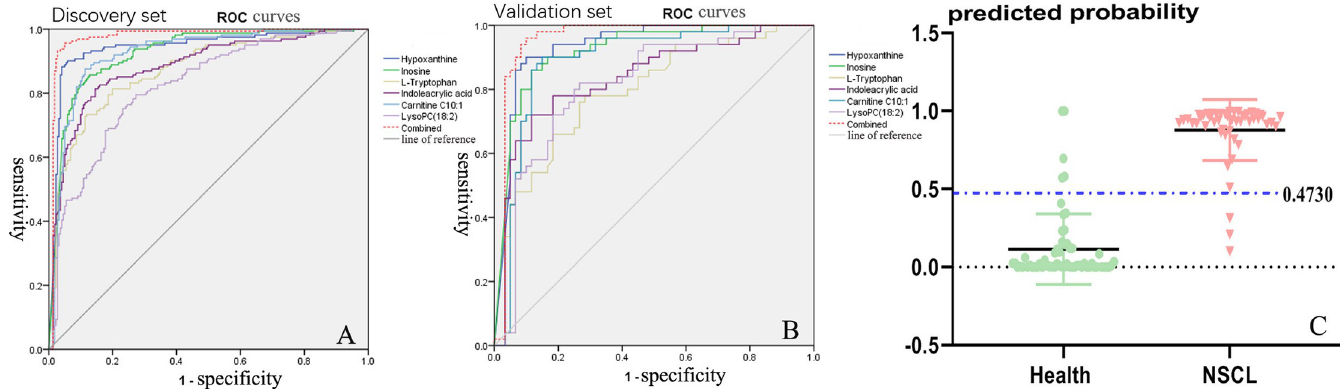
Fig 4. ROC curves of potential metabolic biomarkers for the discovery set (A) and validation set (B); Y-predicted scatter plot (C) of the validation set.